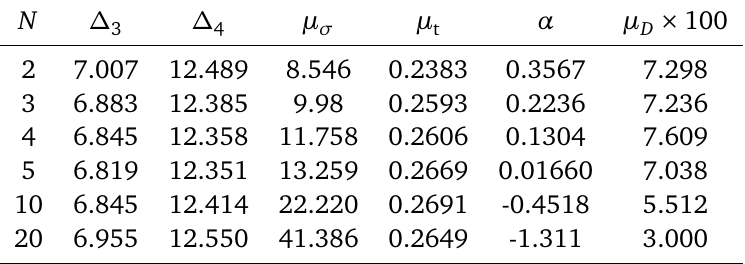
Table 3: CFT data from the ( 4,3 ) truncation for integer values of N ≥ 2 with input data from table 1. ∆ , ∆ refer to dimensions of unknown bulk operators that are 3 4 found by minimization. Values are only reported up to first few significant